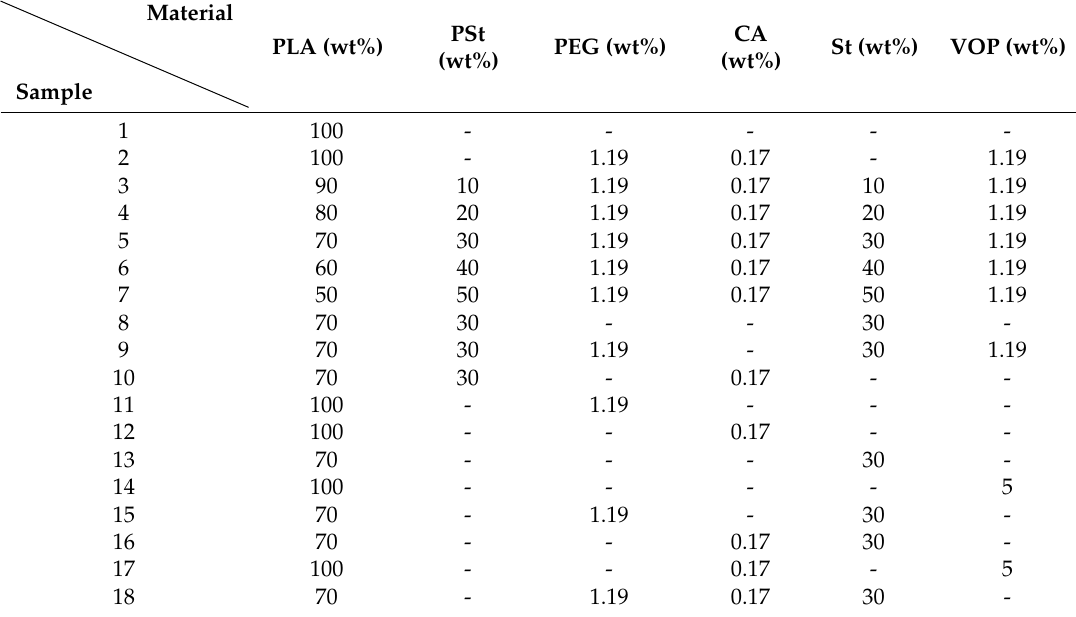
Table 1. Material